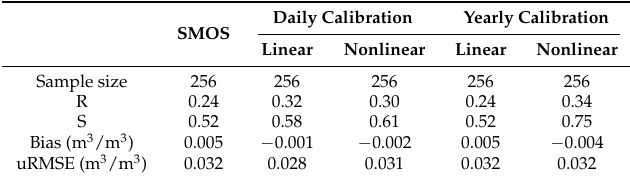
Table 7. Same as Table 4, but for